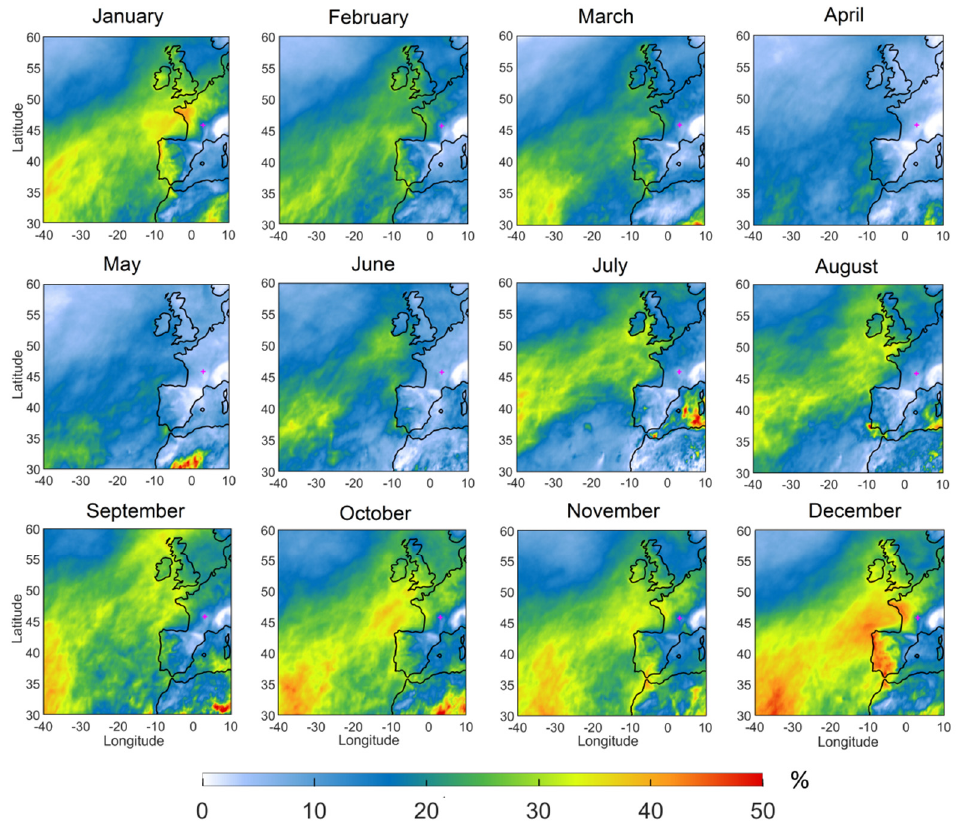
Figure 3. Monthly percentage of precipitation linked to the presence of AR over the period 1980–2020 from January ( top left ) to December ( bottom right ). The location of Clermont-Ferrand is marked by a pink cross.